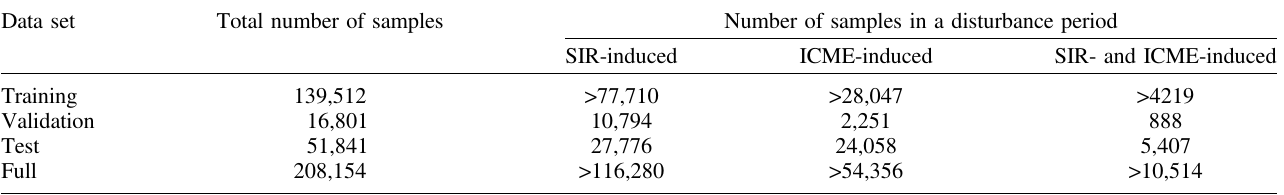
Table 1. Number of data samples in each set, including the number of samples belonging to a disturbance period. Data